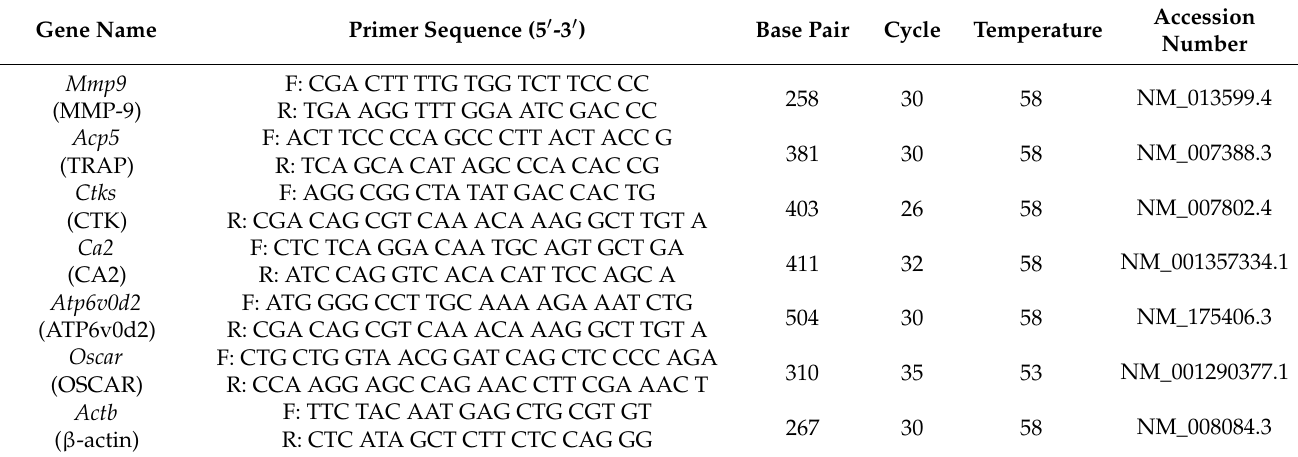
Table 1. Primer sequence for RT-PCR